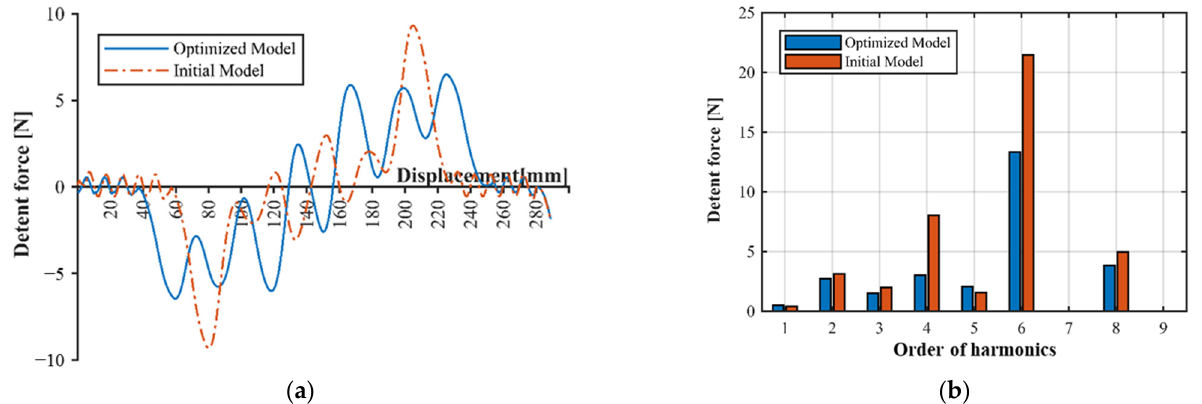
Figure 19. FEM results of end effect detent force at no load ( a ) Detent force of optimized model; ( b ) Detent force harmonic components of optimized model.